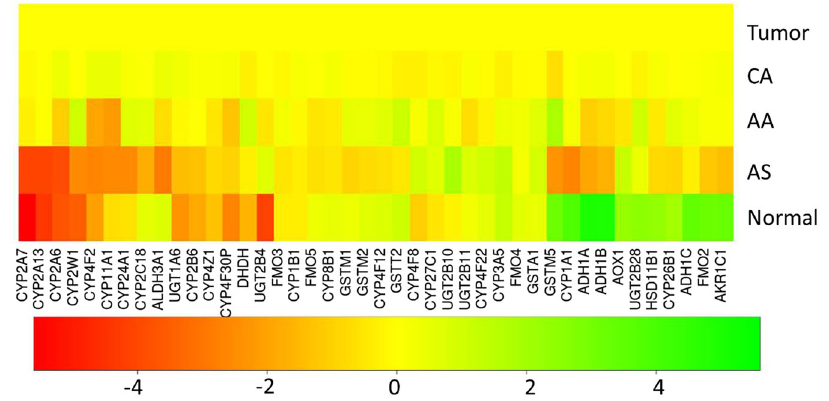
Figure 1. The expression of 42 drug and xenobiotics metabolizing enzymes across breast cancers for Caucasian American (CA), African American (AA), Asian American (AS), all BRCA cancer samples from the three races (Tumor), and all normal samples from the three races (Normal). The mean expressions of all tumor BRCA samples (Tumor) were used as a reference and relative mean expression values from other groups were plotted using a color scheme to show qualitative differences. The values represent fold changes of different groups vs. Tumor group. There are totally 42 DXME genes that display significant differential expression between at least two comparisons (Tables 1 and S2, fold change ≥ 2 and adjusted p-value ≤ 0.05).